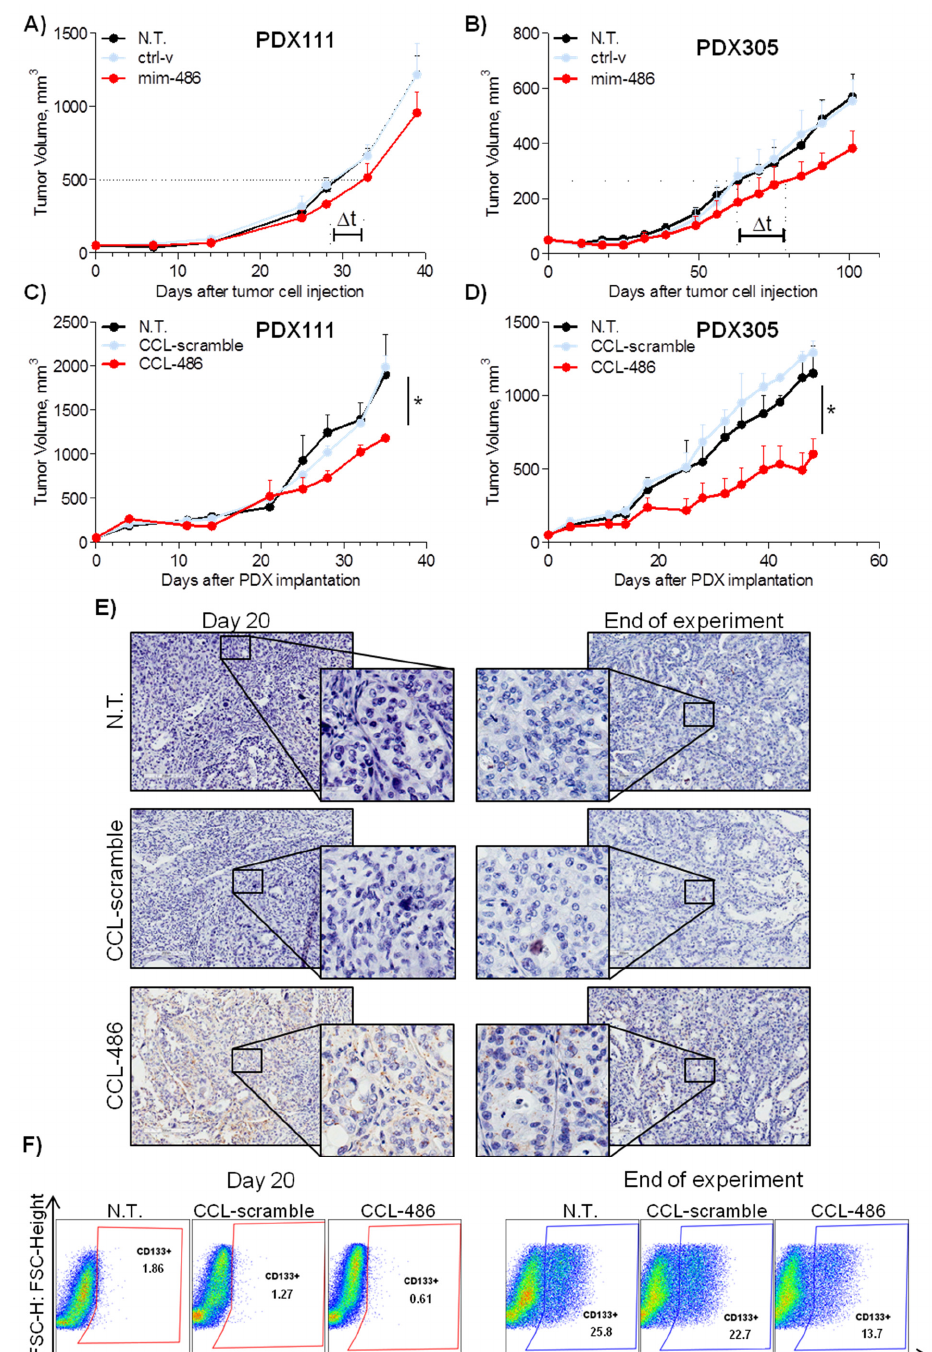
Figure 6. miR-486 reduces in vivo tumor growth and CD133+ cell percentage in PDXs. ( A , B ) Cells derived from two different PDXs (PDX111 and PDX305) and transfected with mim-486 show a delay in growth ( ∆ t) compared to non-transfected or control vector-transfected cells when injected subcutaneously in SCID mice. ( C , D ) CCL-486 administered intraperitoneally twice a week significantly decreases growth of PDX111 and PDX305 injected subcutaneously in SCID mice compared to untreated and control vector-treated PDXs. ( E ) In situ hybridization (ISH) analysis indicates miR-486 expression only in CCL-486-treated PDXs both after 20 days and at the end of the experiment. ( F ) Representative FACS analysis indicates a reduction in CD133+ cells levels in CCL-486-treated PDXs compared to those in untreated and control vector-treated PDXs, both after 20 days and at the end of the experiment. All in vivo growth data are expressed as mean ± standard error of the mean